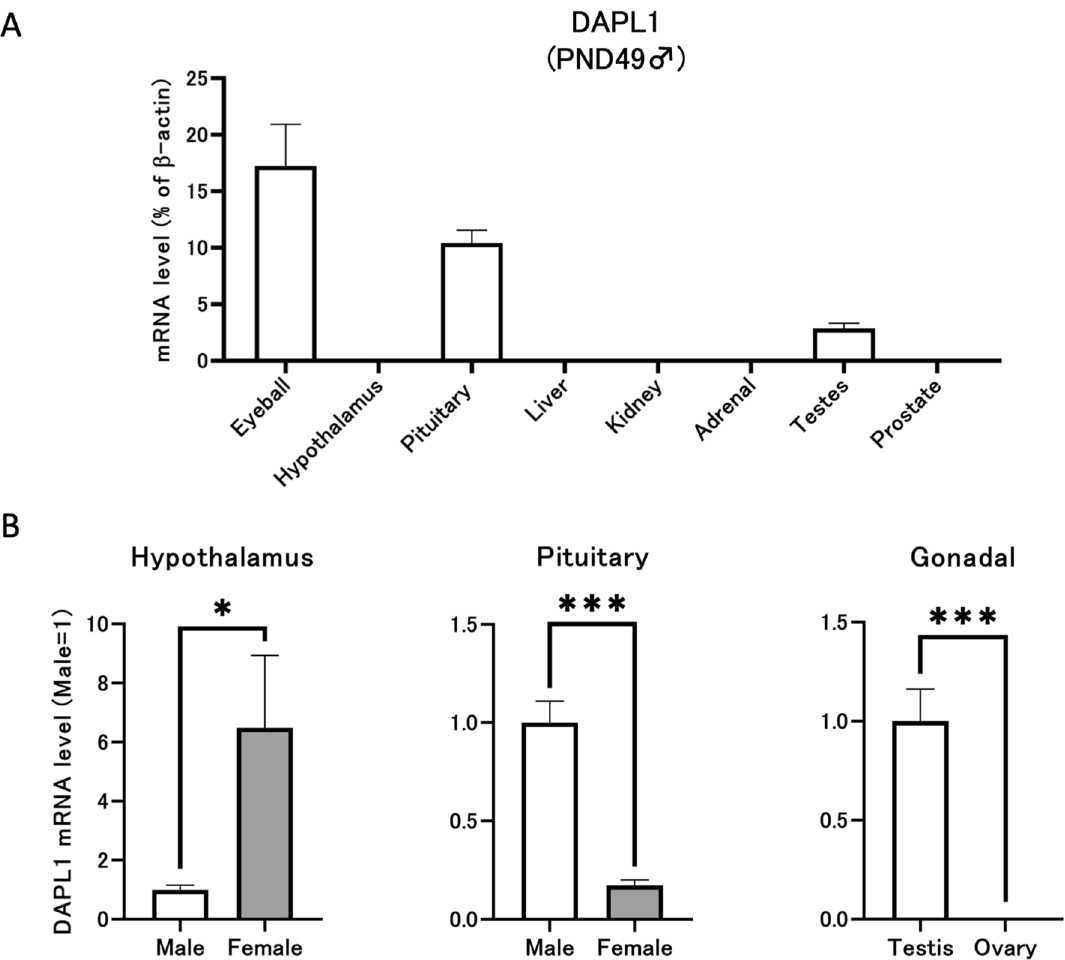
Figure 1. Comparison of DAPL1 mRNA expression levels between different tissues and in the same tissue from different genders. ( A ) DAPL1 mRNA expression levels in different tissues from adult mice were compared. Each bar represents the mean ± S.E.M. of 3–9 mice. ( B ) The mRNA expression of DAPL1 in the hypothalamus– pituitary–gonadal axis of adult wild-type mice were compared between male and female. Each bar represents the mean ± S.E.M. of 5–6 mice. Significantly different from the male group: *p < 0.05, ***p < 0.001. DAPL1 death- associated protein-like